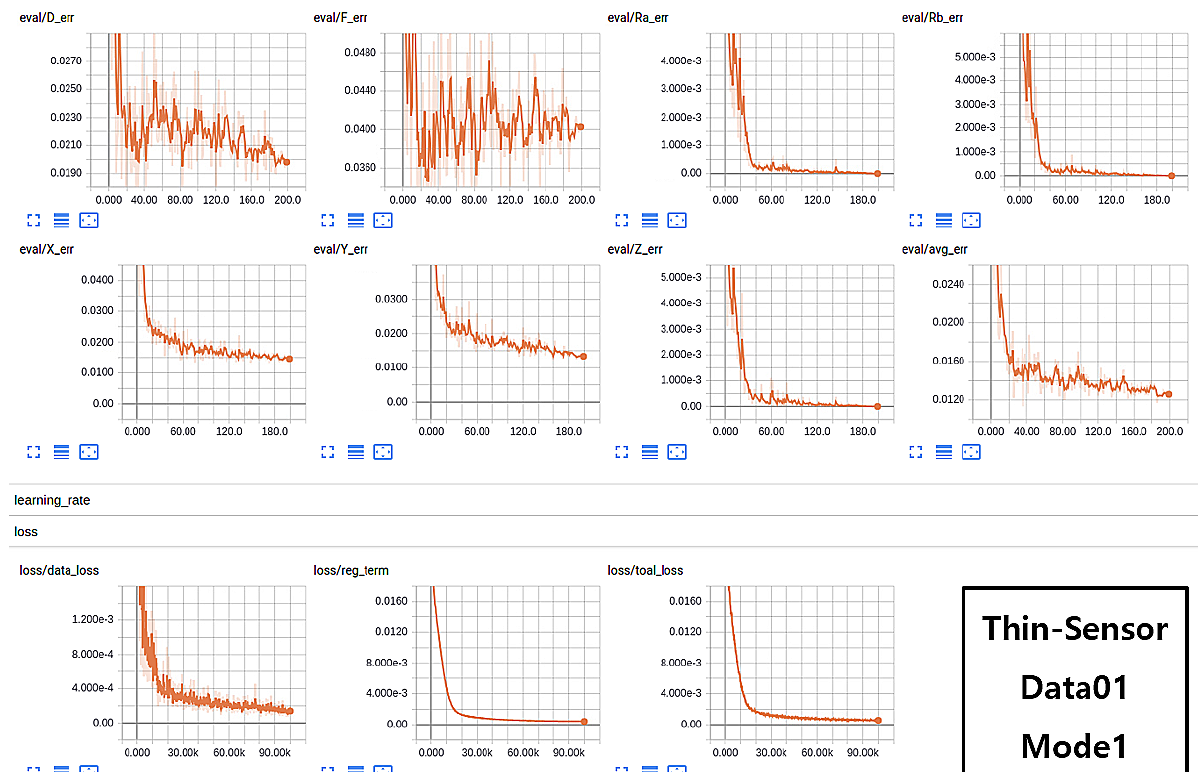
Figure 13. Successful case scenario of network training on thin sensor data (Data01) in the form of Mode1.